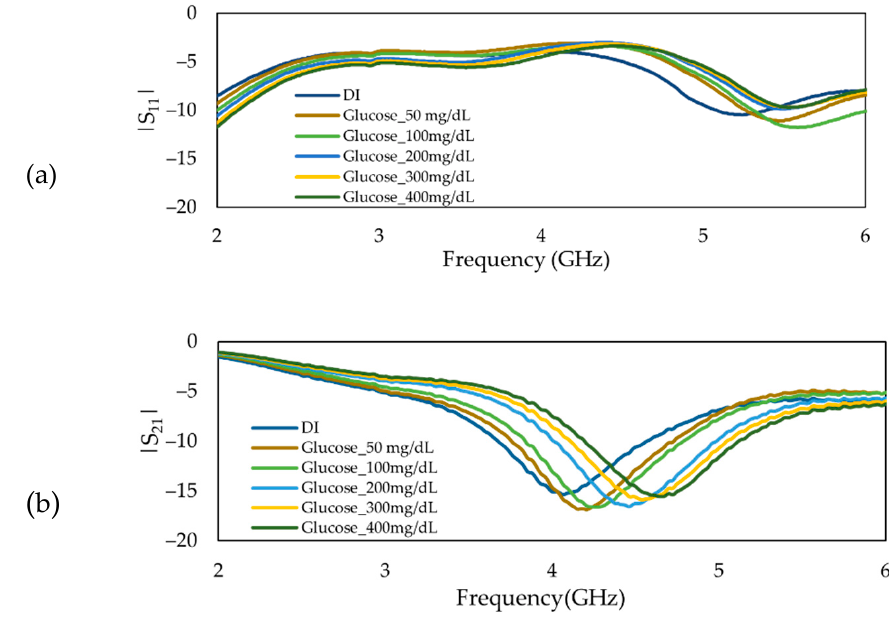
Figure 9. Measured vs. simulated frequency response of the insertion loss ( S 21 ) for flow channel filled with air and DI water.